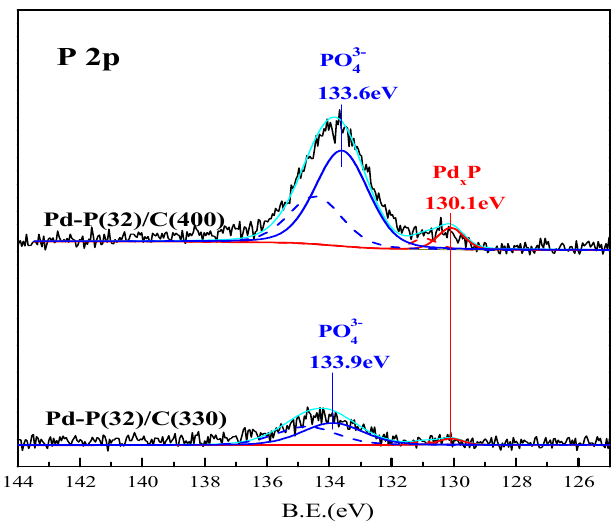
Figure 5. X-ray photoelectron spectroscopy (XPS) spectra of Pd 3d 5/2 for PdO/C, Pd-P(32)/C(330), and Pd-P(32)/C(400).